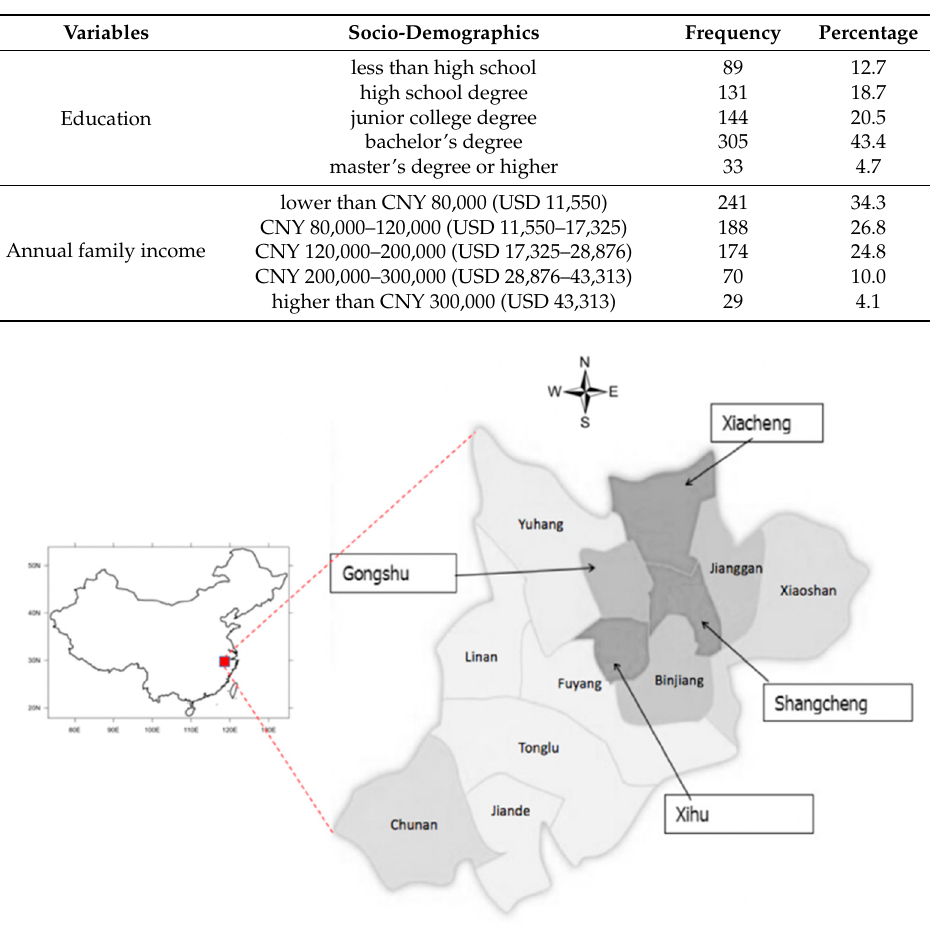
Figure 2. Location of the study area. The study was conducted in four districts (Gongshu, Xiacheng, Shangcheng, and Xihu) of Hangzhou, China.